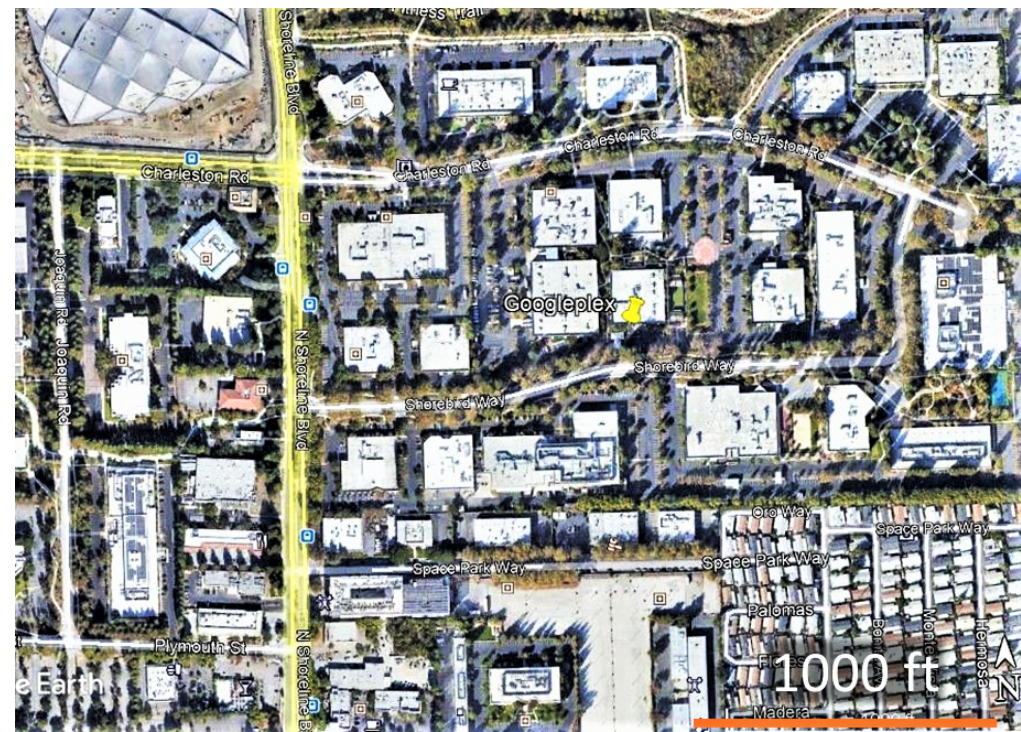
Figure 2. Google campus (Googleplex) at Mountain View, CA where studies on a monarch breeding population were conducted during January–May 2021 (Google Earth image).